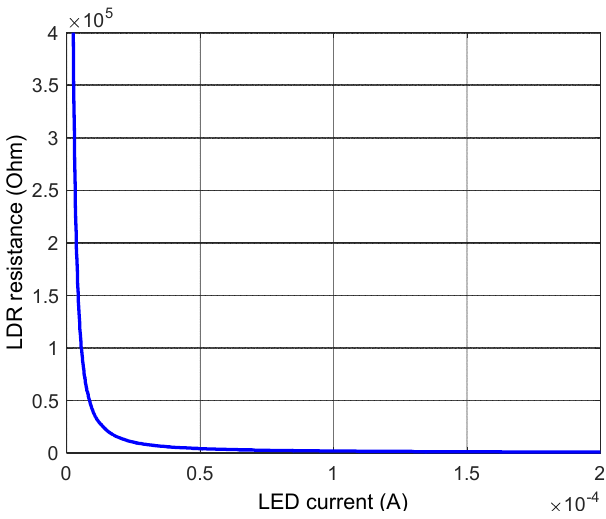
Figure 7. LDR experimental results, R LDR versus LED current.